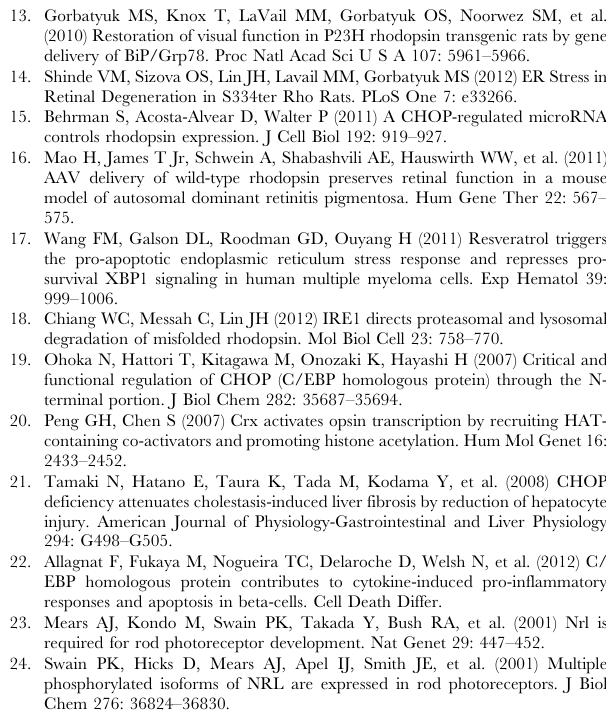
Figure S2 Alteration of retinal structure in the T17M RHO CHOP 2 / 2 retinas. A: SD-OCT images were captured in 1-month-old live mice. B: Thickness of the Outer Nuclear Layer (ONL) was measured in the superior and inferior retinal hemispheres in 1-month old mice. Measurements were made at a distance of 100, 200, 300 and 400 m m from the optic nerve head. The ONL in the T17M RHO and T17M RHO CHOP 2 / 2 retinas was significantly thinner compared to that of wild-type or CHOP 2 / 2 retinas at corresponding time points. Also, significant difference (*** P value , 0.001) in ONL thickness was observed between the T17M RHO and T17M RHO CHOP 2 / 2 retinas. RNF&GCL: retinal nerve fiber and ganglion cell layer; INL: Inner nuclear layer, OPL: Outer plexiform layer, ONL: Outer nuclear layer, OLM: Outer limiting membrane, IS/OS; inner and outer segments of photoreceptors and RPE: retinal pigment epithelium. (TIF) Figure S3 Ablation of the CHOP protein in ADRP retina does not modulate the miR-708 expression. We analyzed all four groups of one-month-old mice (N = 3) and found no difference between them when compared by one-way Anova. However, T -test comparison revealed that there is a statistically significant difference between CHOP 2 / 2 and T17M RHO CHOP 2 / 2 mice suggesting that the ER stress promotes reduction of miR-708 in CHOP deficient